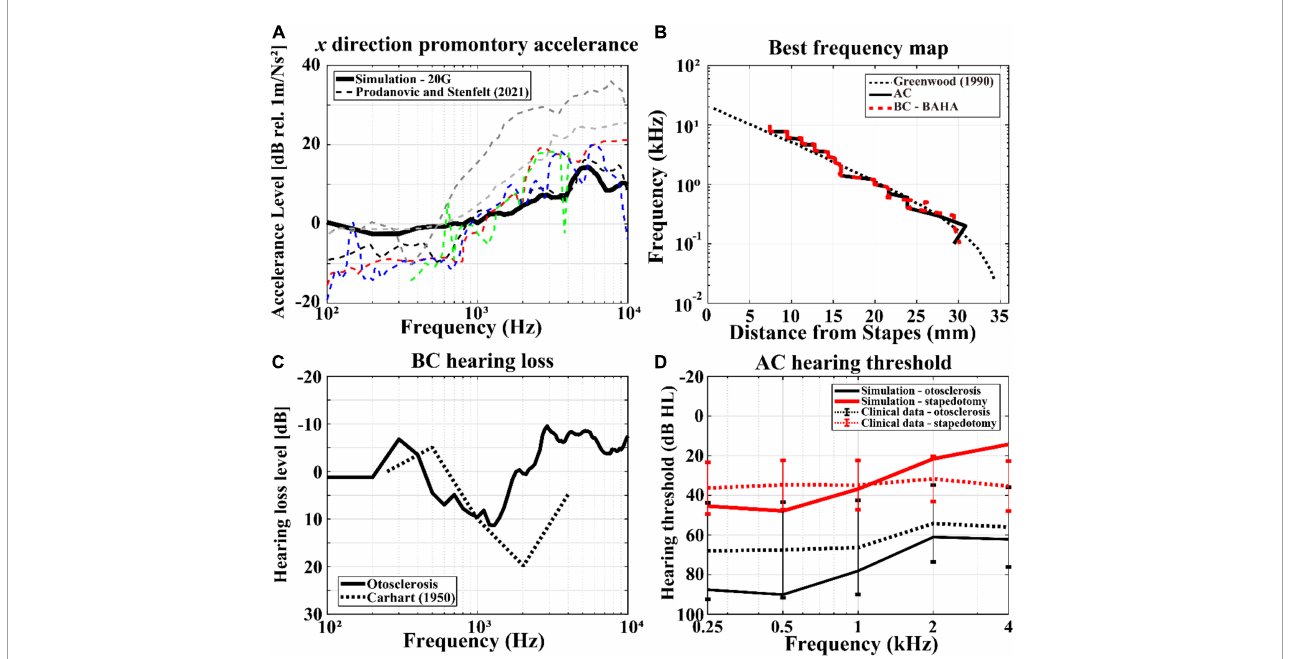
FIGURE4 Validations of the current finite-element (FE) models. The simulation results are represented by solid lines, whereas those of the previous studies or clinical data are shown as dashed lines: (A) promontory accelerance, (B) BF maps according to AC and BC stimulations, (C) BC hearing losses including Carhart’s notch, and (D) hearing thresholds in AC stimulation with otosclerosis (black lines) and stapedotomy (red lines) conditions. In (D) , the error bars represent the 95% confidence interval of the measurements’